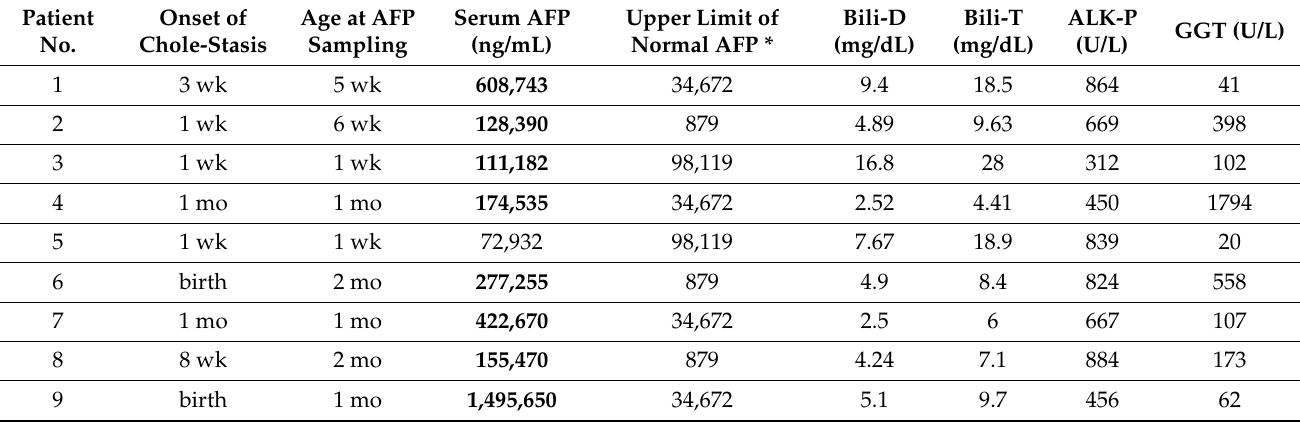
Table 2. Biochemical Characteristics of 9 patients with